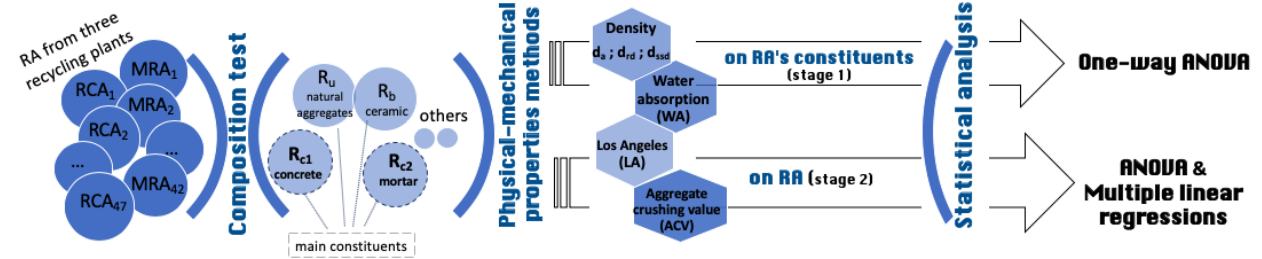
Figure 3. Experimental program.